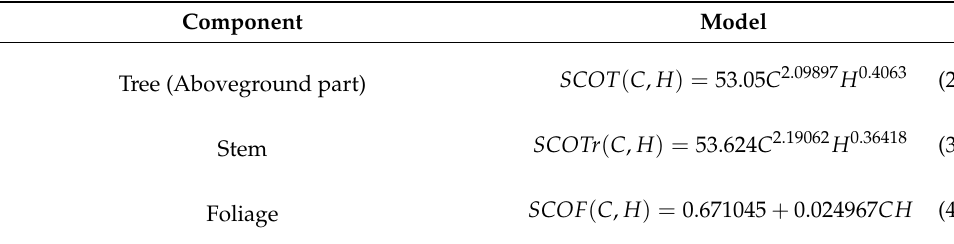
Table 3. Carbomass models used in this study.